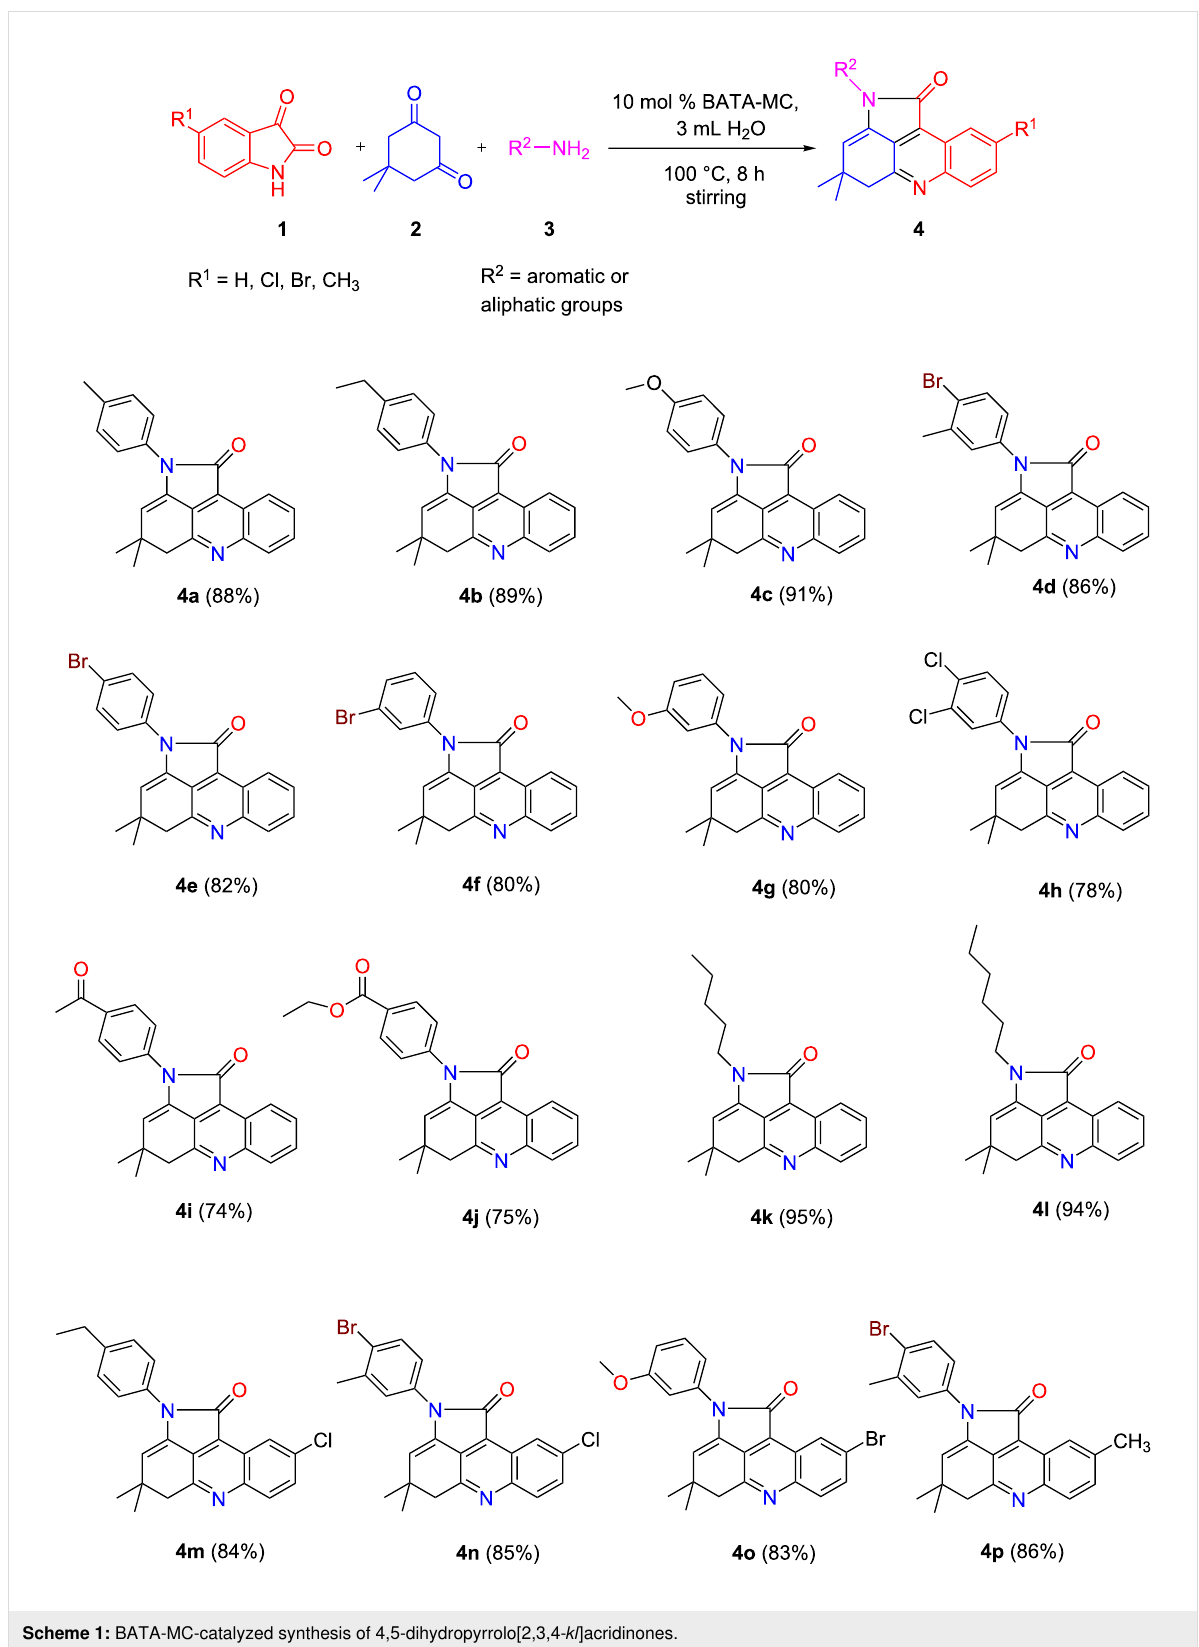
Scheme 1: BATA-MC-catalyzed synthesis of 4,5-dihydropyrrolo[2,3,4- kl